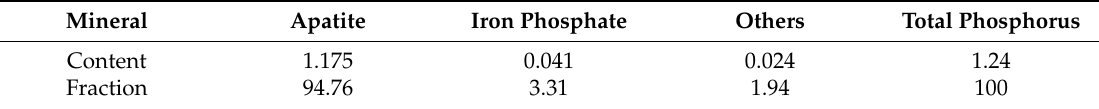
Table 2. Chemical phases and distribution of phosphorus in oolitic hematite ore /wt. %.